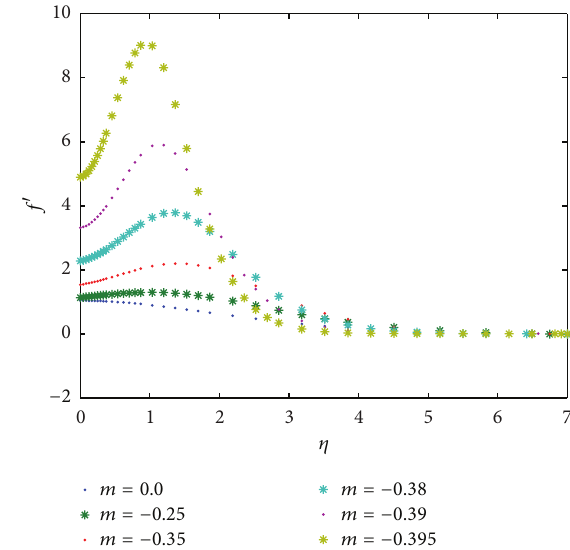
Figure 2: Approximate solution of the value ℎ against 𝜂 for selected values of 𝑚 .